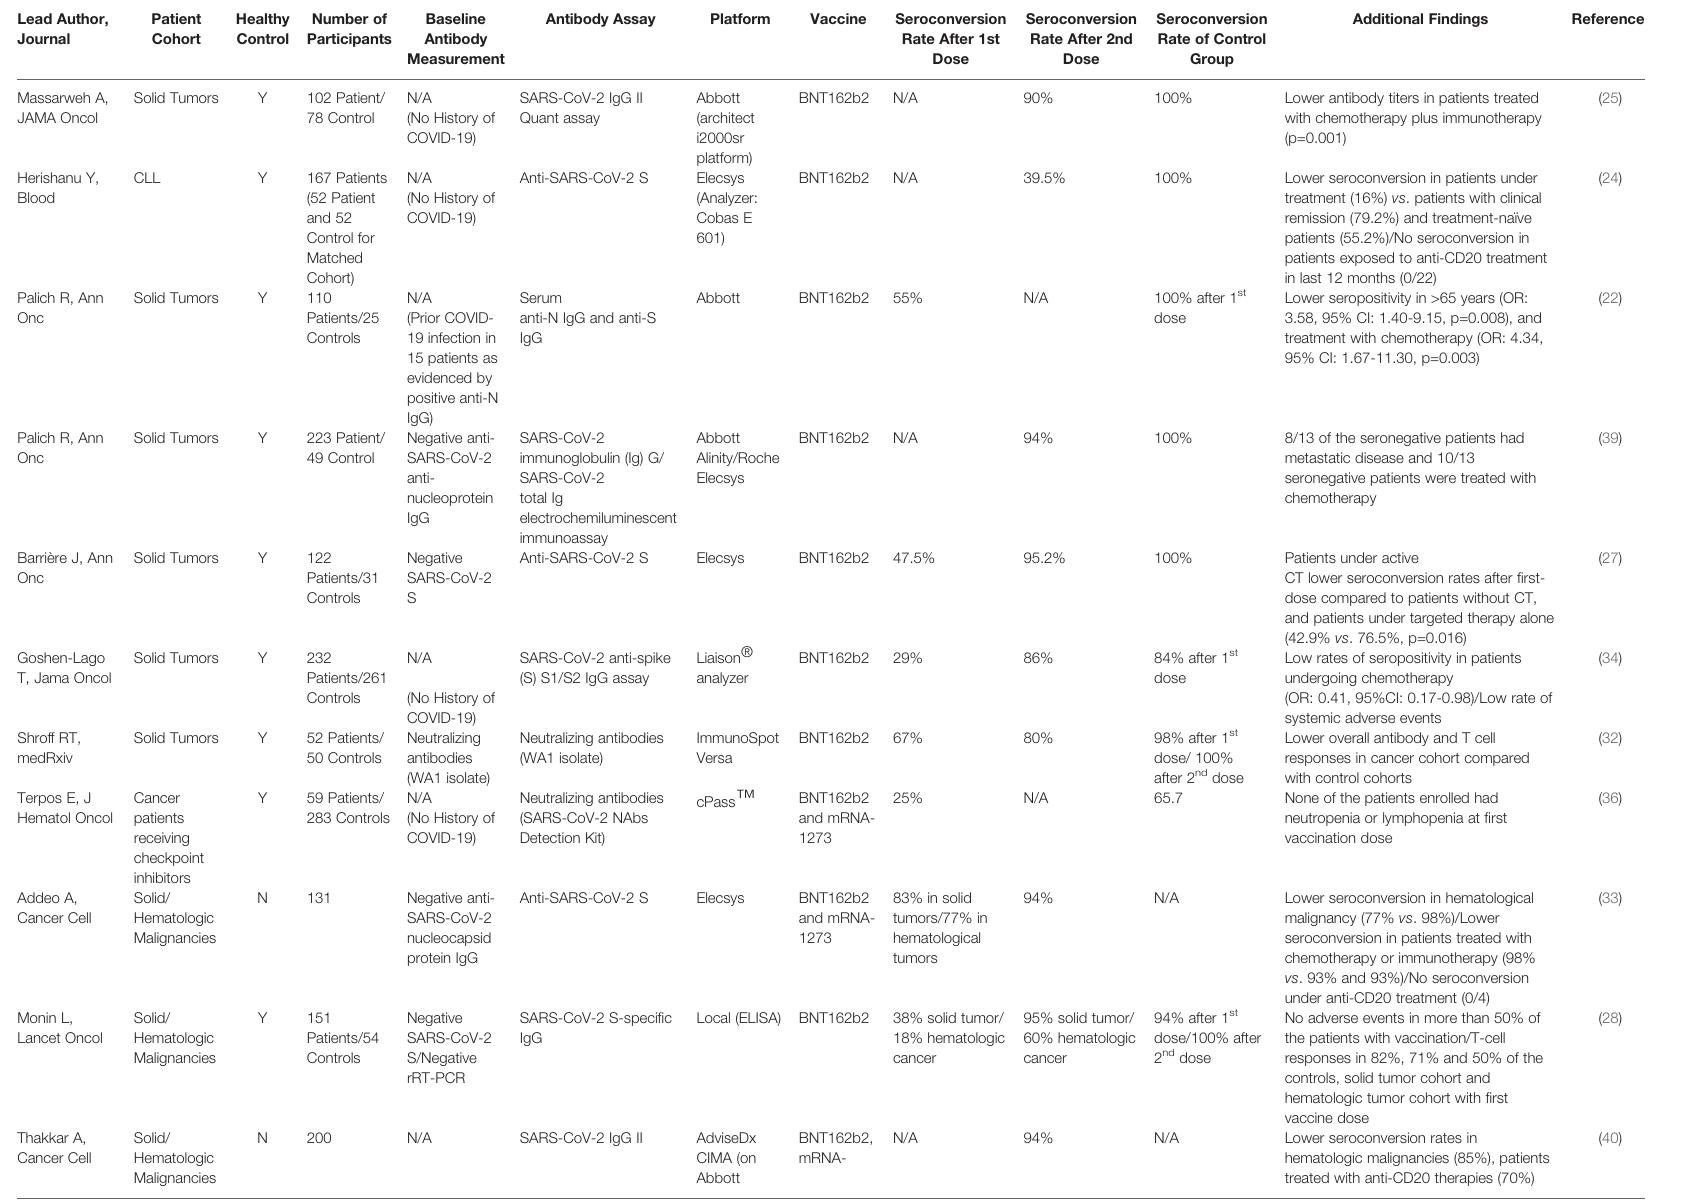
TABLE 2 | Summary of studies evaluating antibody responses to SARS-CoV-2 vaccination. Lead Author,